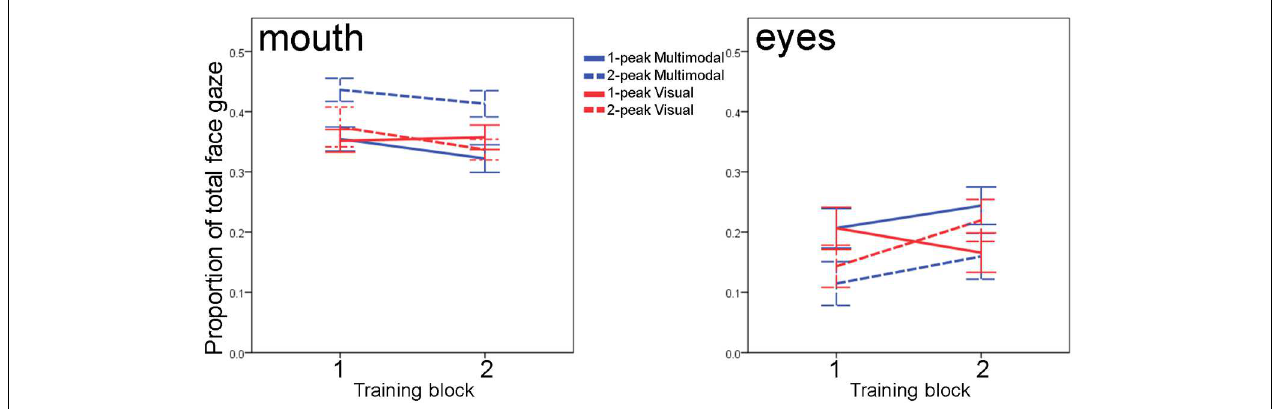
FIGURE 4 | Infants’ fixations to the speaker’s mouth (left) and eyes (right) calculated as proportions to total face gaze, for each of the two blocks of the training phase. Solid lines vs. dashed lines reflect 1-peaked vs. 2-peaked trainings; color differentiates between multimodal (blue) and visual (red) trainings. Error bars denote one standard error of the